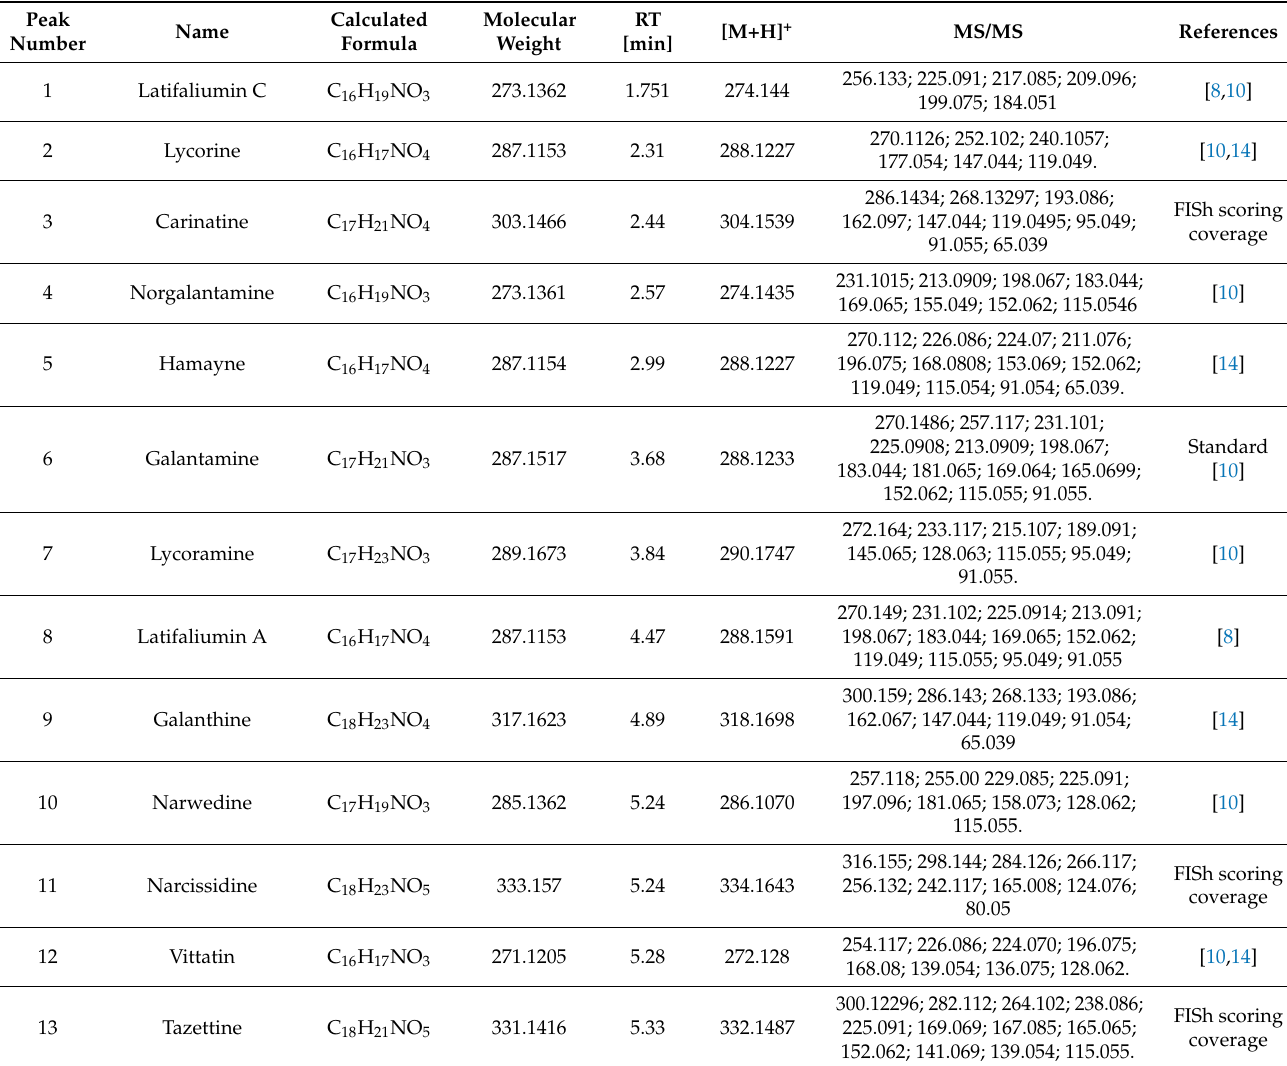
Table 3. The alkaloids detected in the Narcissus bulbs of the five